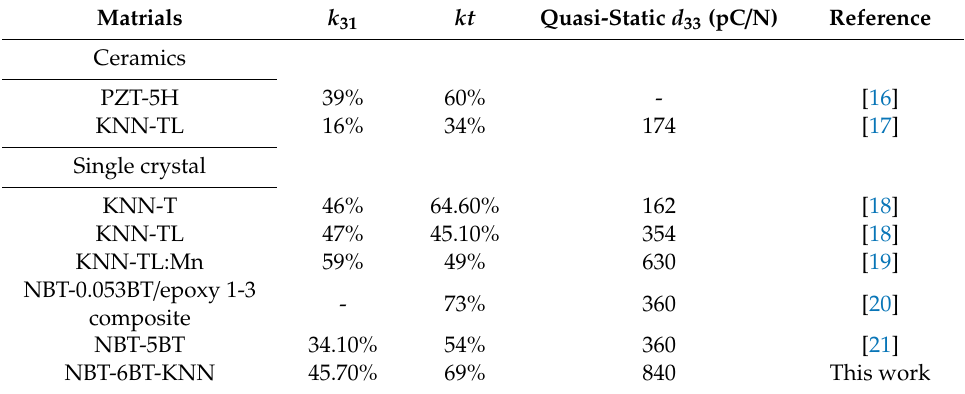
Figure1. ( a )thethicknessmodeand( b )31modeimpedanceandphaseangleofthepoledNBT-6BT-KNN Figure 1. ( a ) the thickness mode and ( b ) 31 mode impedance and phase angle of the poled crystal along the < 001 > direction at room temperature; the temperature dependent behavior of ( c ) k t NBT-6BT-KNN crystal along the <001> direction at room temperature; the temperature dependent and ( d ) k 31 . behavior of ( c ) k t and ( d ) k 31 . Table 1. Comparison of the properties of previously reported ceramic / single